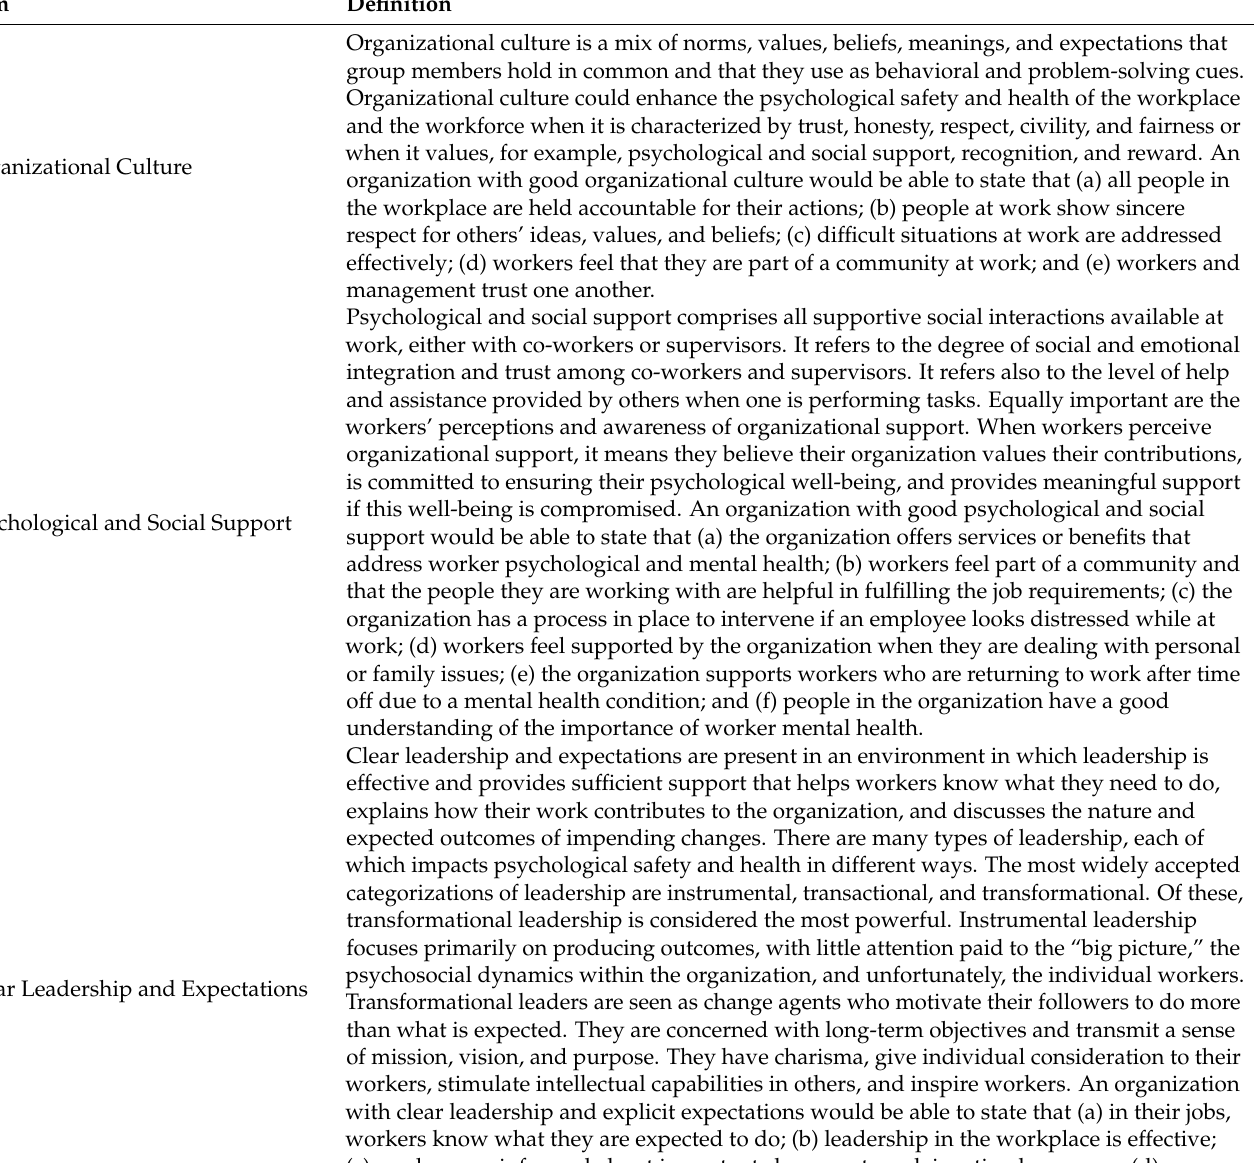
Table A1. Workplace Factor Definitions from the National Standard of Workplace Psychological Health and Safety